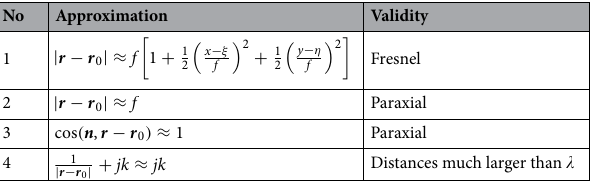
No Approximation Validity